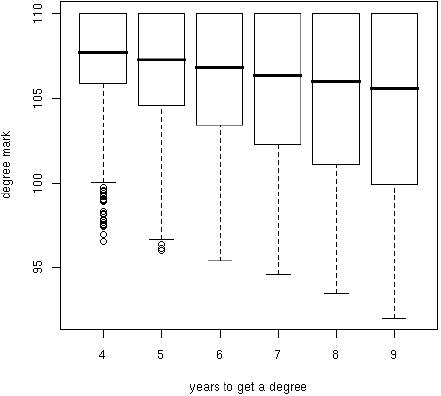
Figure 6 – Boxplots of the conditional distribution of the final mark (sex=female, place of residence= Macerata, course attendance=regular, diploma mark=lowest) by number of years to get a degree.